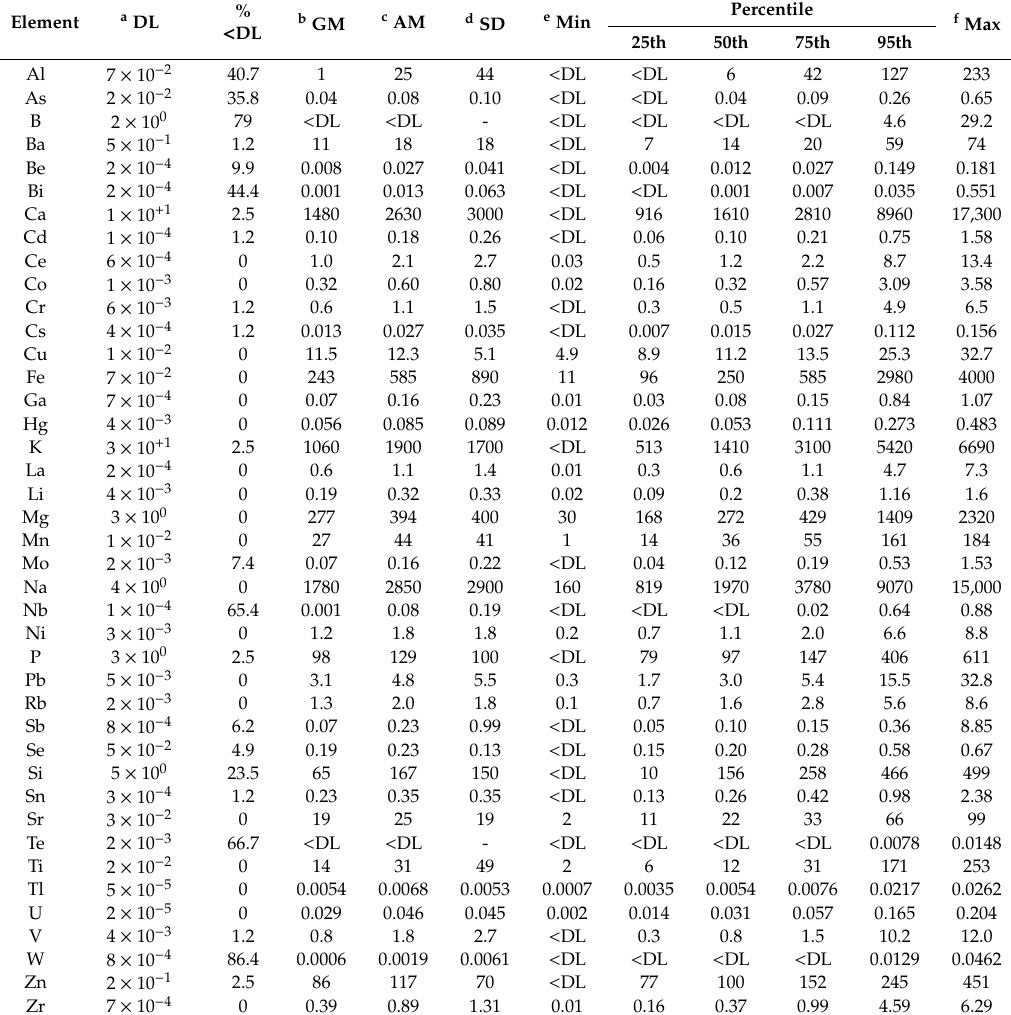
Table 2. Element levels (mg kg − 1 ) in the hair of children living in the Benishangul-Gumuz region in Ethiopia ( n =